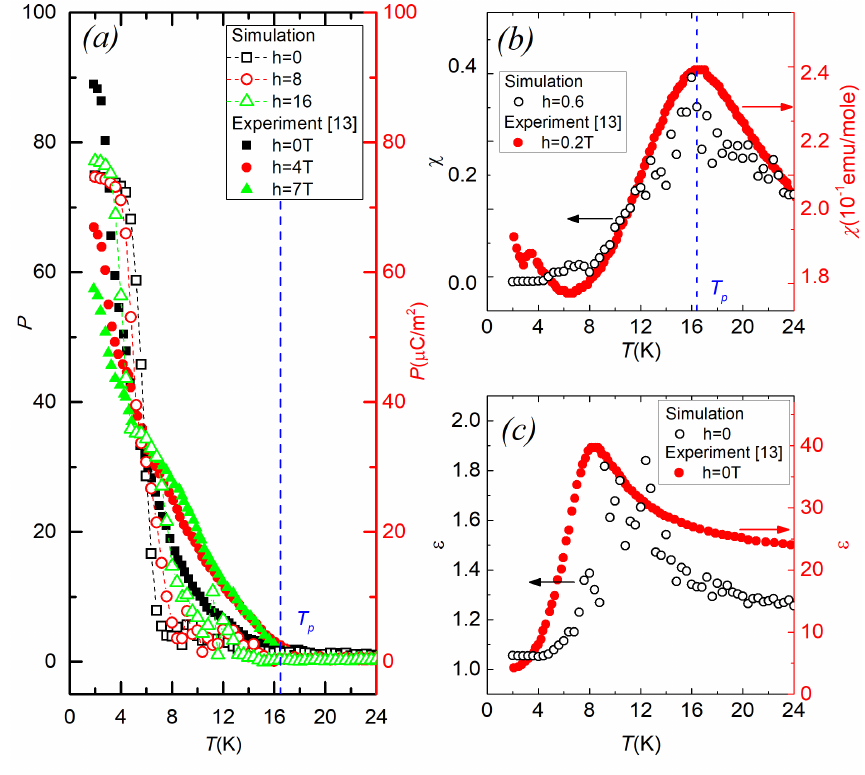
Figure 1. Temperature dependencies of polarization ( a ), magnetic susceptibility ( b ), and permittivity ( c ) were obtained from the simulation (opened symbols) and the experiment (filled symbols)